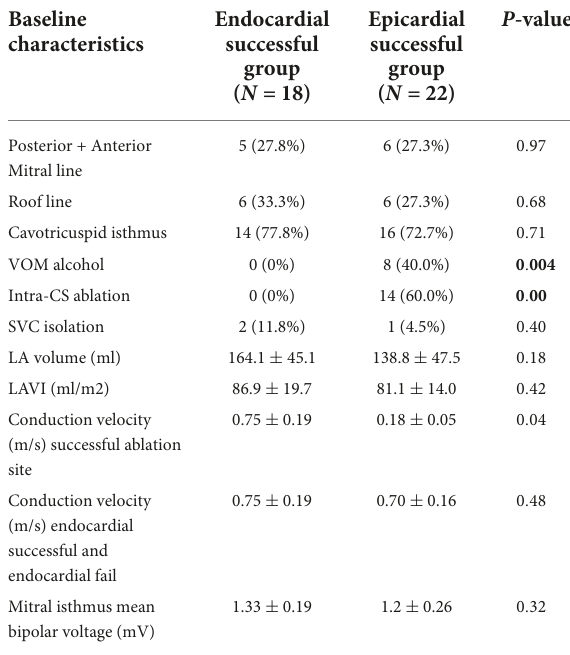
TABLE 1 Baseline